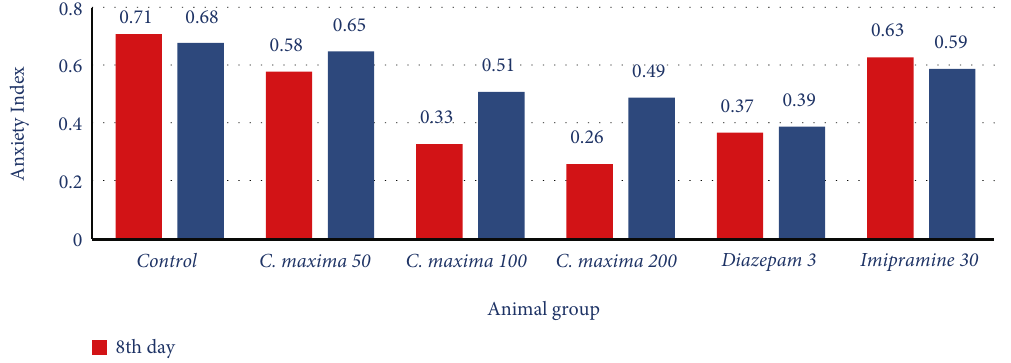
Figure 4: The outcome of C. maxima seeds on anxiety index (EPM). Table 8: E ff ect of C. maxima seed extracts on head dips. Groups and doses